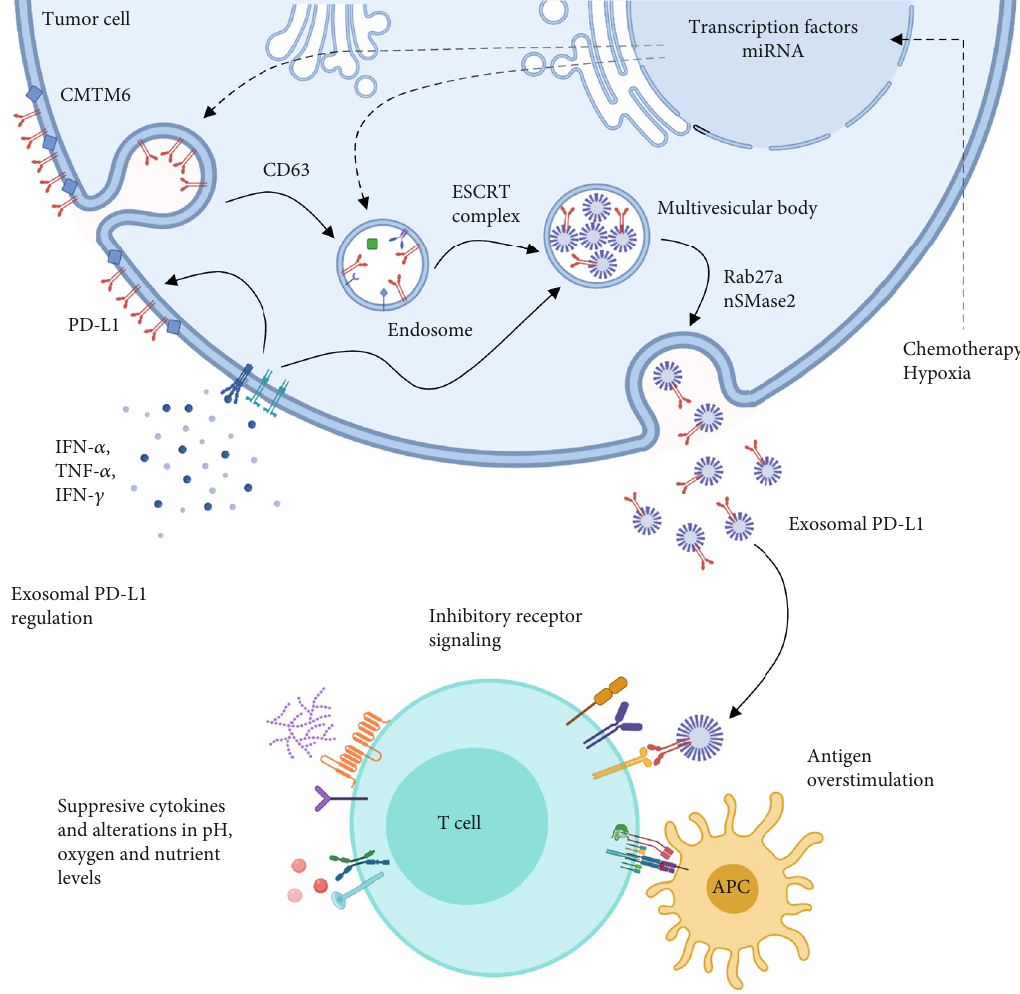
Figure 1: Model of potential biogenesis and release of exosomal PD-L1 and its role in T cell dysfunction. Cytokine signaling in tumor cells increases PD-L1 expression and exosomal PD-L1 biogenesis which is mediated by intracellular vesicular transport proteins, such as CD63 and the endosomal sorting complex required for transport (ESCRT) machinery. Other factors such as hypoxia and chemotherapy may induce exosomal PD-L1 biogenesis, by enhancing the activity of transcription factors and small RNA species via unknown mechanisms (dotted arrows). Rab27a and nSMase2 mediate exosomal PD-L1 release which contributes to T cell dysfunction by inhibitory receptor signaling, in the context of multiple immunosuppressive factors in the